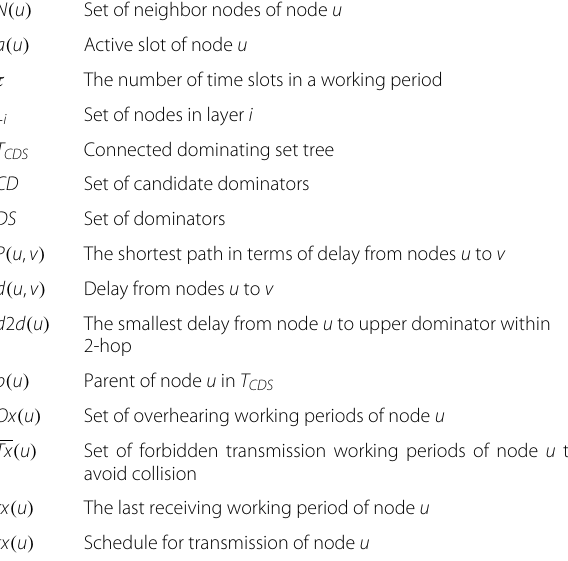
Algorithm 1: Delay-aware tree